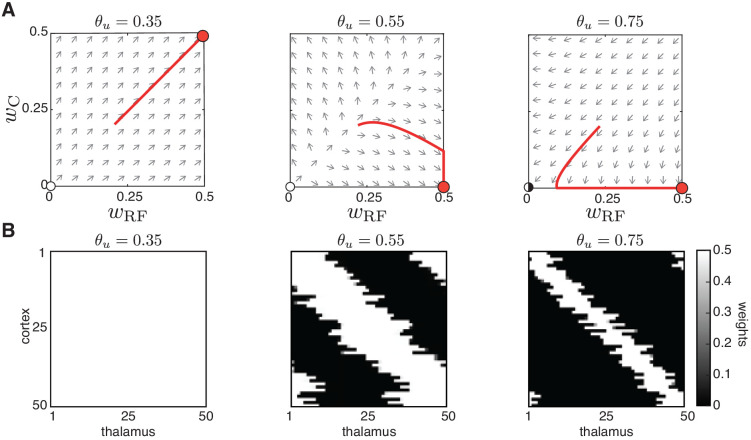
Peripheral L-events generate robust receptive field refinement.(A) The reduced two-dimensional weight dynamics in the phase plane with the same θu as Appendix 1–figure 2B and D. For each plane, the red trajectory depicts the weight evolution from an initial condition where wRF⁢(0)>wC⁢(0) until the weights’ upper bound (wmax=0.5). Left: wC→wmax and wRF→wmax, resulting in no selectivity. Middle and right: wC→0 and wRF→wmax, resulting in selectivity and receptive field refinement. (B) Simulation results for the same input thresholds of Appendix 1–figure 2B,D for the full 50-dimensional system.